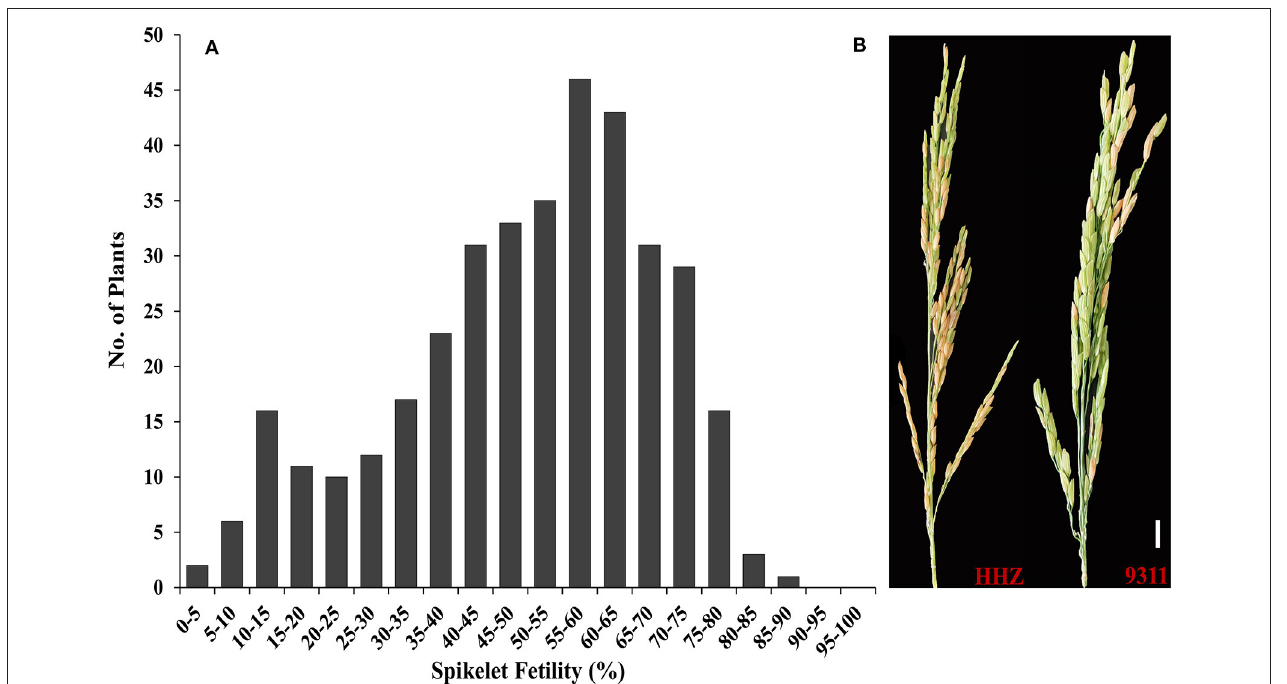
FIGURE 1 | HT evaluation of the two parents and F 2 : 3 population. (A) Frequency distribution of spikelet fertility in the F 2 : 3 population containing 365 plants; (B) HHZ and 9311 under 38 ◦ C for 3 days.